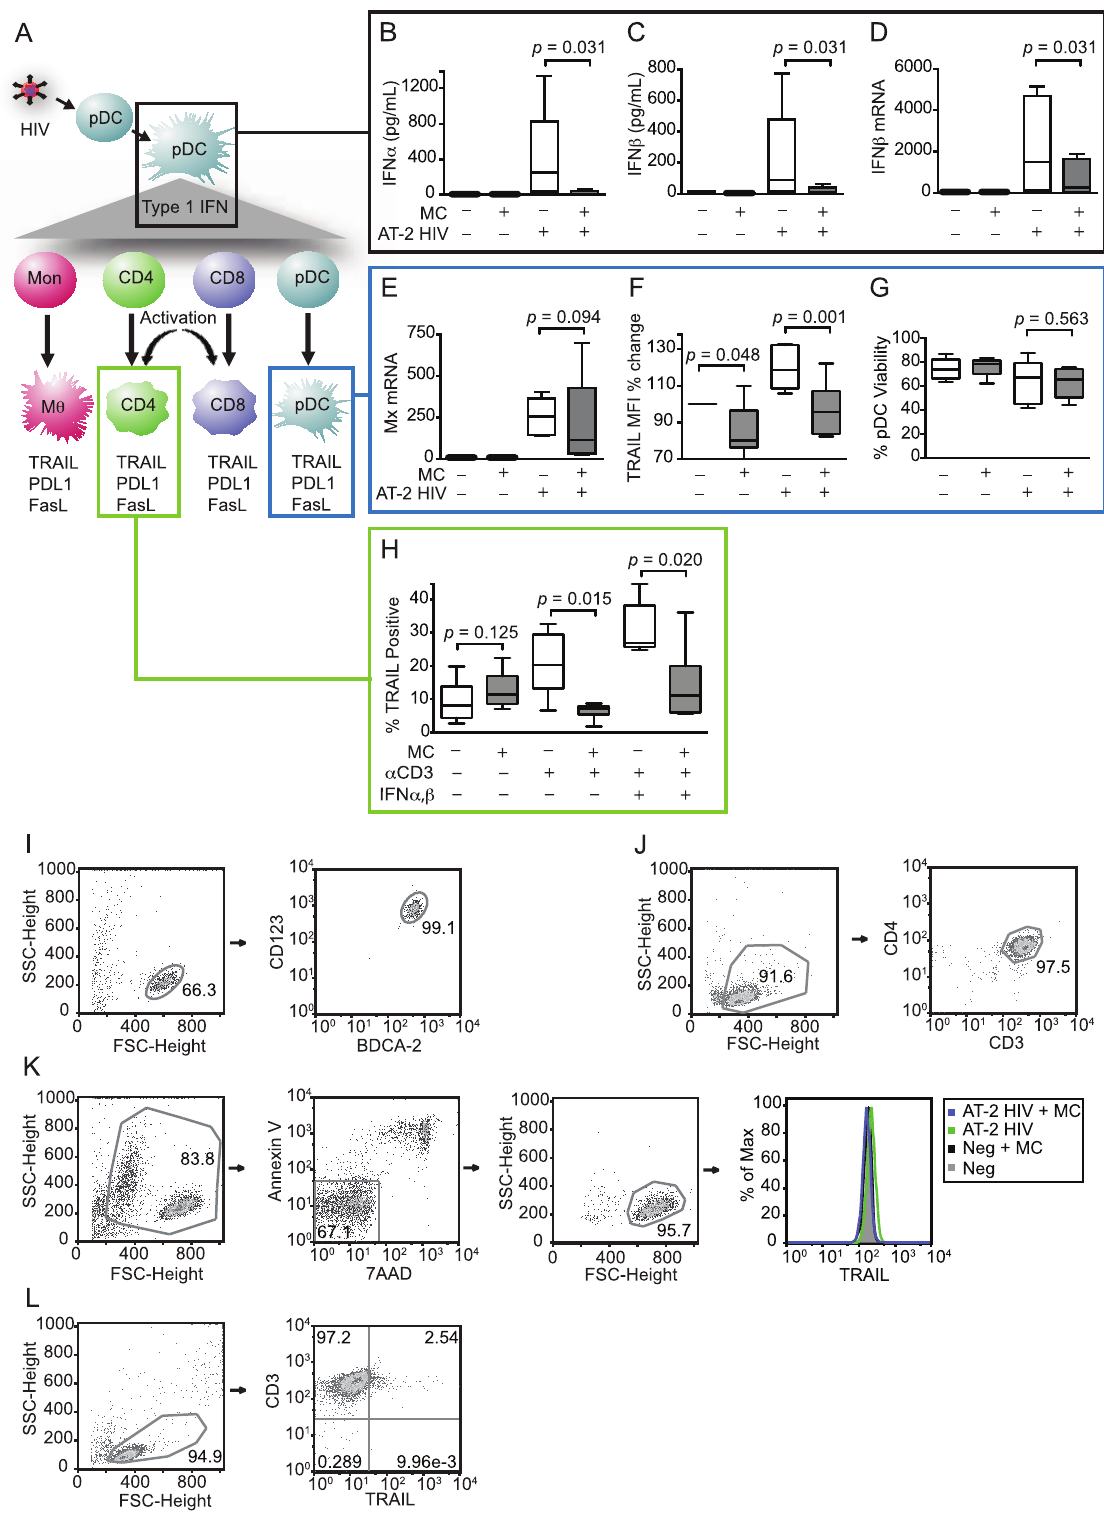
Figure 1. Minocycline prevents TRAIL upregulation in pDCs and CD4 + T cells by attenuating anti-viral IFN and activation responses. (A) pDCs become activated in response to TLR7/9 stimulation by HIV and secrete type I IFN, which in turn upregulates ISGs on leukocytes, including the TNF family members TRAIL and FasL and the B7 family member PDL1. These ligands induce apoptosis and/or exhaustion on target cells expressing the cognate death receptors (TRAIL/DR5; FasL/Fas; PDL1/PD1). (B–G) pDCs were isolated from blood of healthy human donors and exposed to 300 ng p24 eq./mL of AT-2 HIV with or without 20 m M minocycline for 18 hours ( n =6 different donors). (B, C) IFN a and IFN b protein from pDC supernatants were measured by ELISA. (D) IFN b mRNA was measured by qRT-PCR. (E) Mx mRNA and (F) TRAIL were measured as examples of